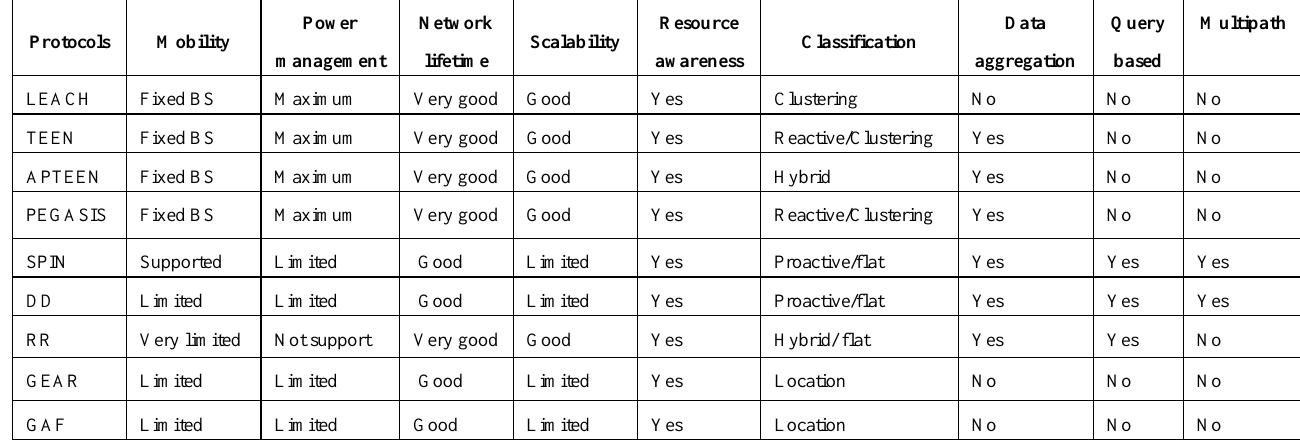
Table 1. Comparison of different routing